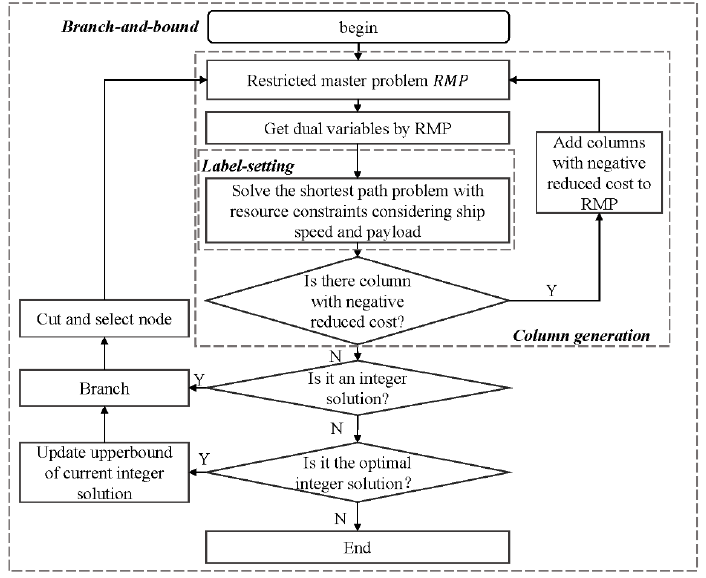
Figure 4. Flow chart of branch-and-price algorithm.